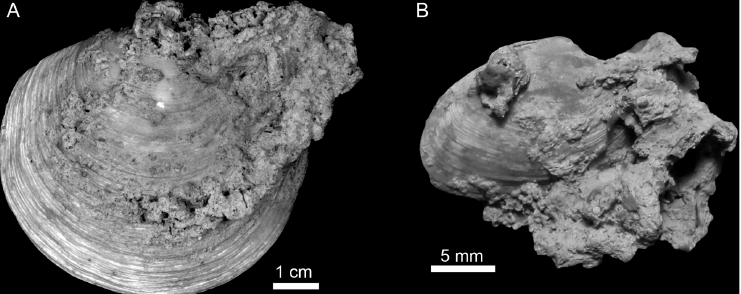
Fig. 10. Incipient methane-driven cementation of matrix on valves of chemosymbiotic bivalves from GBPF, precursors of seep-limestones: (A) Lucinoma kazani encrusted by carbon-depleted concretion ( δ 13 C – 37.57‰ PDB, see text), (B) Isorropodon perplexum , almost com- pletely embedded in